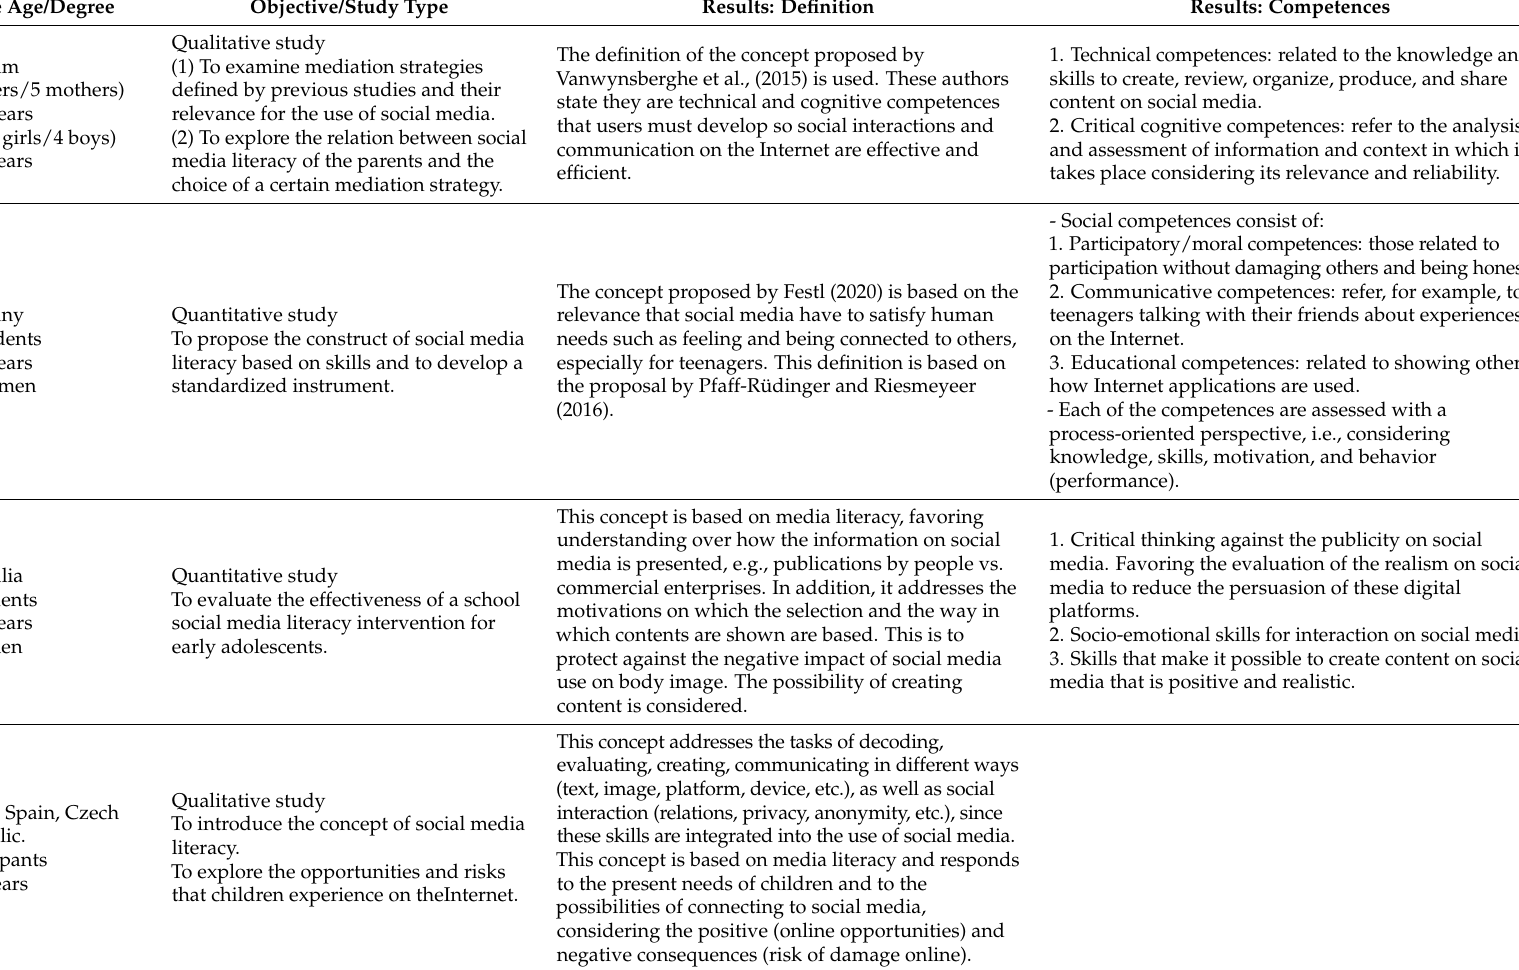
Table A1. Concept and competences of Social Media